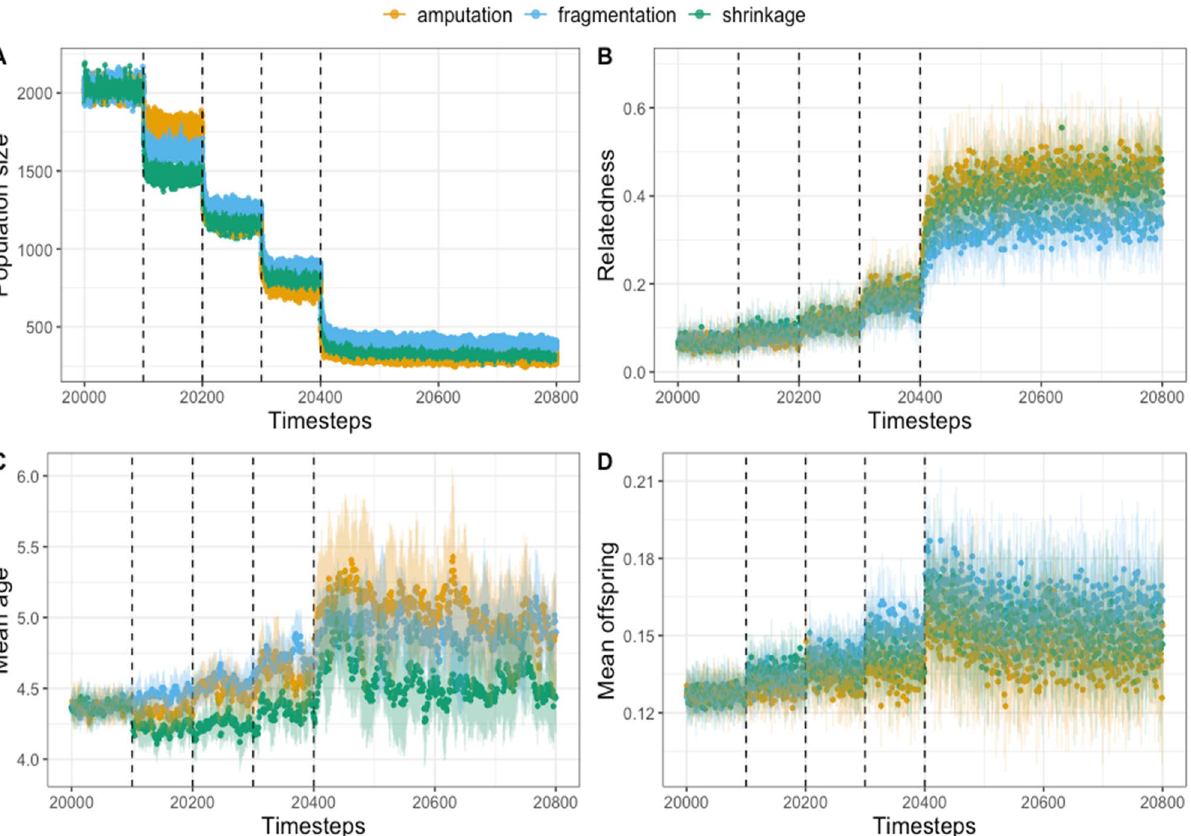
Figure 2. Effects of three simulated patterns of range contraction (amputation, fragmentation, and shrinkage) on ( a ) population size following each discrete range contraction event; ( b ) pedigree relatedness across timesteps following contraction; ( c ) mean age of individuals in the population following range contraction; ( d ) mean number of offspring across timesteps for each replicate. Dashed lines represent the timing of each discrete range contraction event; each point is the mean and lines are the standard deviation of 10